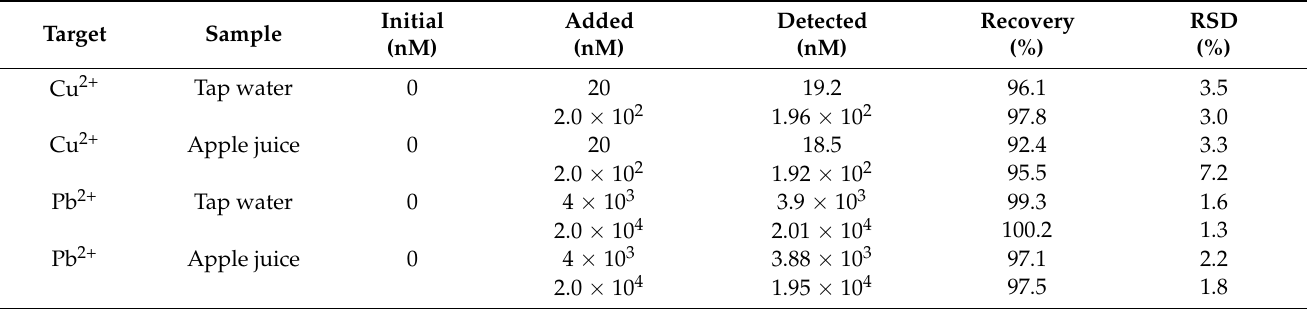
Table 2. Recoveries of CQDs/QDs@ZIF-67 in spiked samples (n =